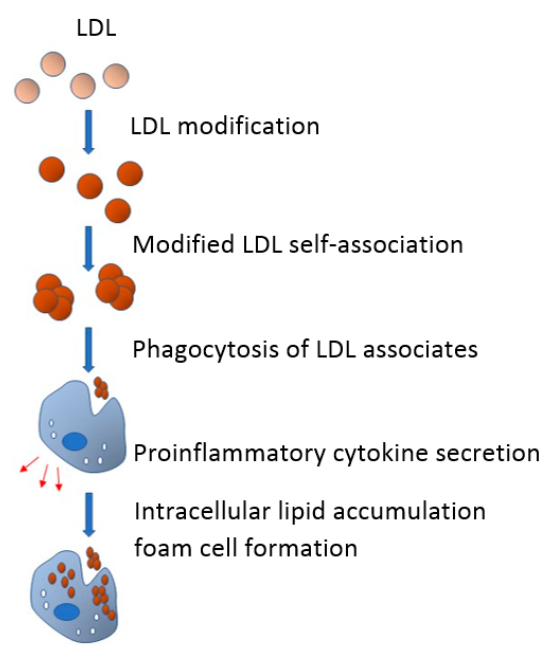
Figure 3. In the blood flow, LDL undergoes multiple modifications and acquires atherogenic properties. Modified LDL particles have a tendency to form self-associates that, in turn, promote phagocytosis of subendothelial arterial cells. Being triggered by phagocytosis, proinflammatory response emerges and proinflammatory cytokines are secreted. Proinflammatory cytokines promote or even cause the accumulation of intracellular lipids, which leads to the formation of foam cells.